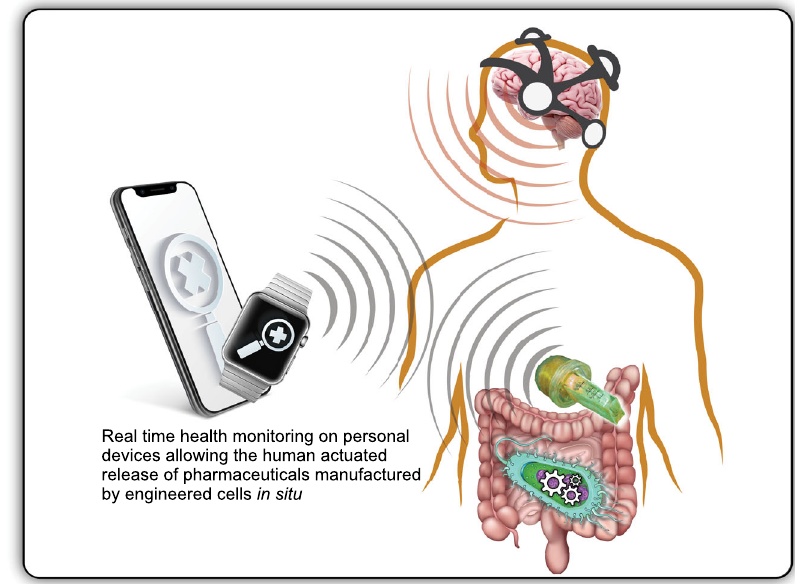
Fig. 5 Optogenetic designer cell implants bio-informationally integrated with wearables, personal devices, and EEG-based actuation for speci fi c use cases. Longer-term applications include viewing health information on a personal device reported via a subcutaneous optogenetic device with bioelectrical monitoring properties. Engineered microbiomes could both report real-time patient data and deliver on-demand pharmaceuticals in